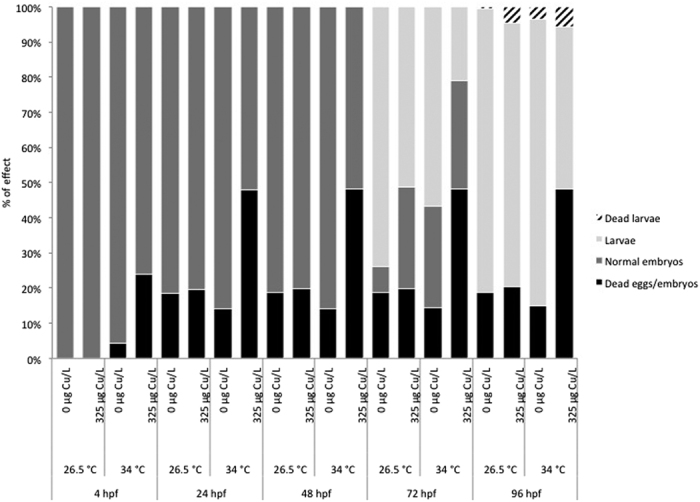
Proportion of eggs and embryos that died during the 96 hours experiment (black bars), proportion of embryos that stayed alive (dark grey bars), that hatched (i.e., larvae, light grey bars) and proportion of larvae that died (spotted dark grey bars) following exposure of zebrafish embryo from <1 to 4 hpf to 325 μg Cu/L at either 26.5 °C or 34 °C.